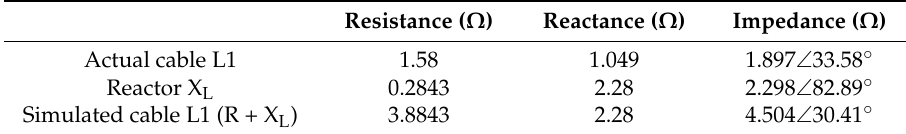
Figure 3. Reactor for simulating electric cable. ( a ) Three-phase reactors; ( b ) Equivalent circuit of the reactor. Table 1. Parameters of actual and simulated cable